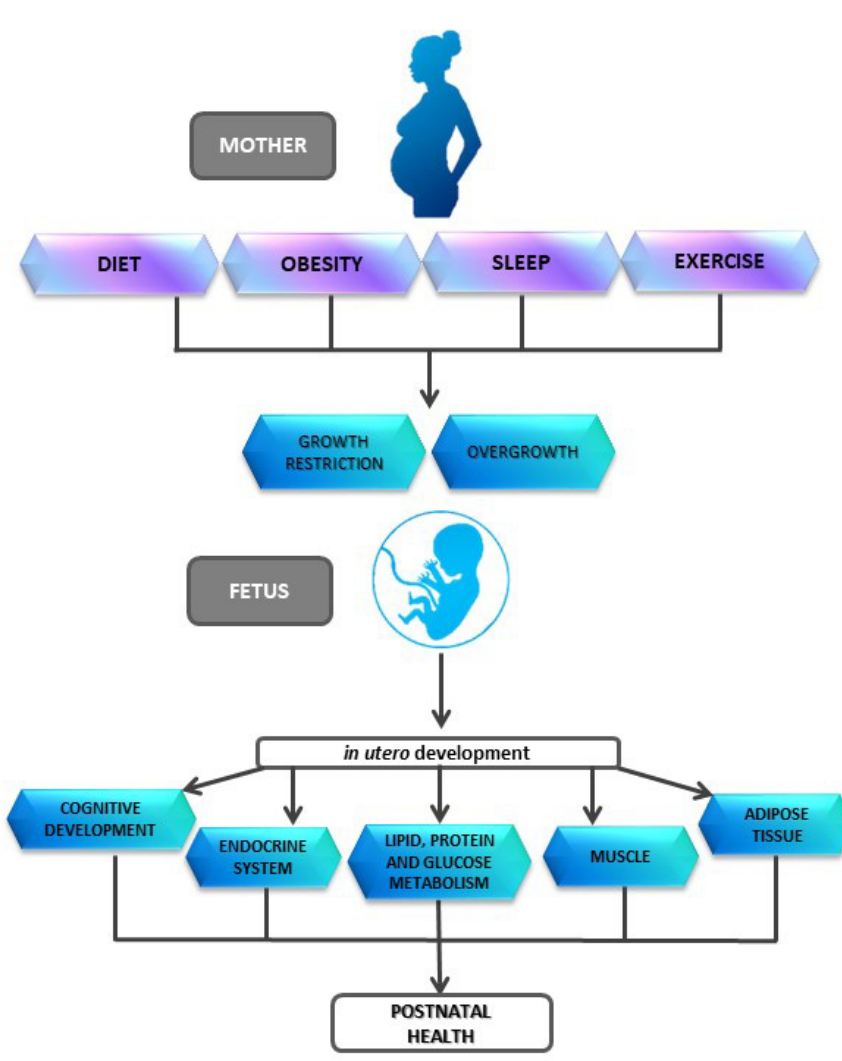
Figure 1. Influence of several factors on offspring development .